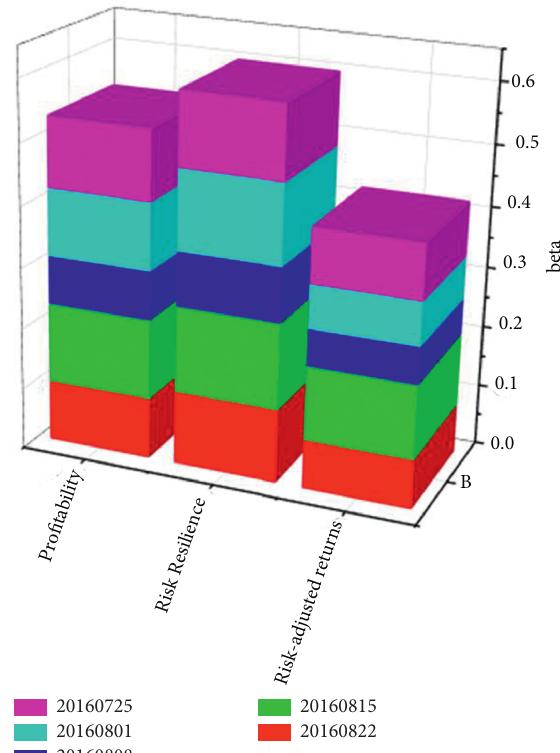
Figure 8: Size of each risk value at different times.